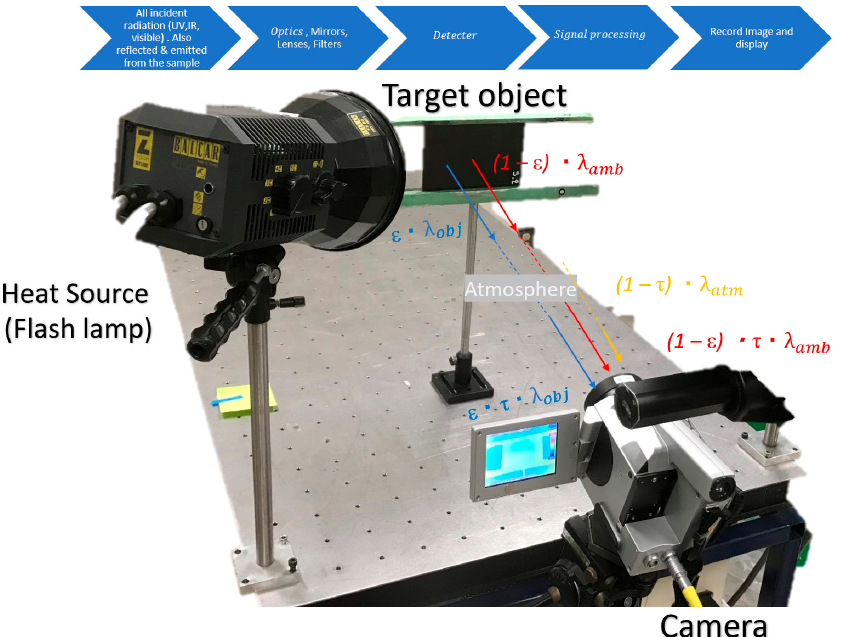
Figure 3. Visualisation of the inspection with regards to the emitted and absorbed radiation. The blue arrows display the process of the IR camera [11].